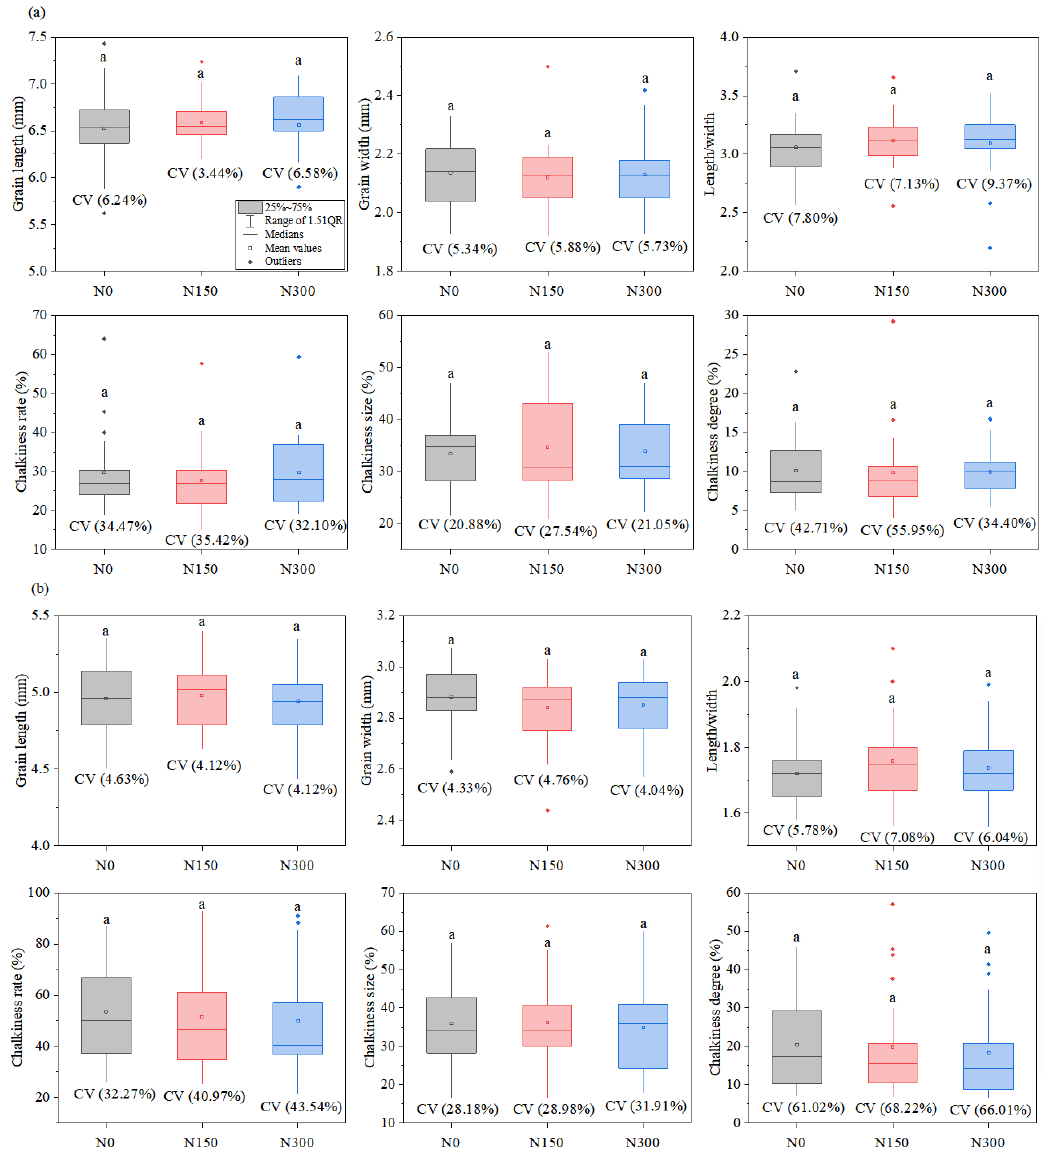
Figure 1. Distribution chart of grain shape and appearance quality for hybrid indica rice varieties ( a ) and inbred japonica rice varieties ( b ) with different nitrogen levels. The values of different lowercase letters refer to significant differences at p < 0.05 among different nitrogen levels. The CV value refers to the coefficient of variation. N0, N150, and N300 refer to treatments with 0 kg ha − 1 , 150 kg ha − 1 , and 300 kg ha − 1 applied.